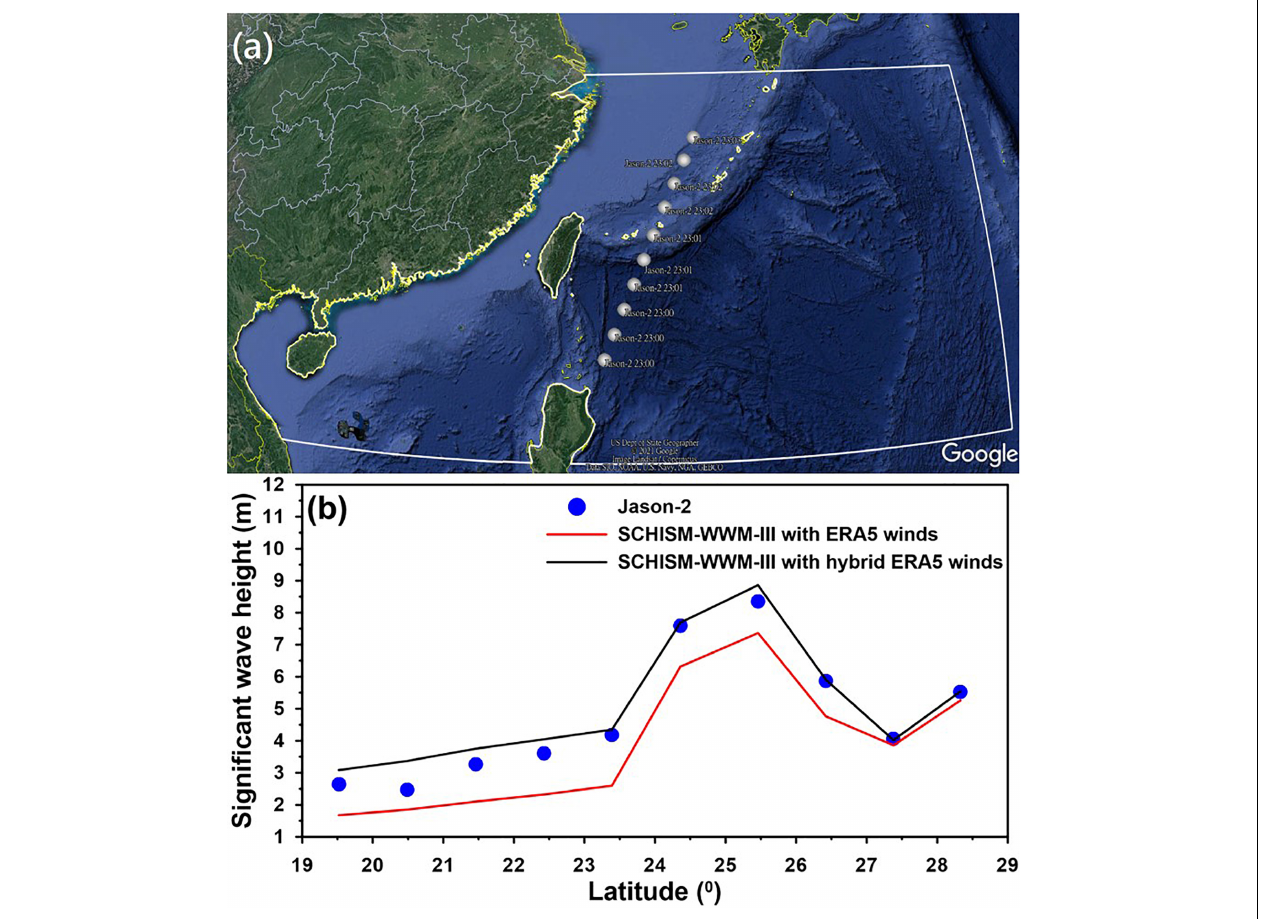
FIGURE 4 | (a) Jason-2 orbit in the computational domain at UTC 23:00 on July 9, 2018, and (b) along-track significant wave heights measured by altimeter on Jason-2 with hindcasted significant wave heights derived from the original ERA5 and modified ERA5 wind fields for Super Typhoon Maria in 2018.